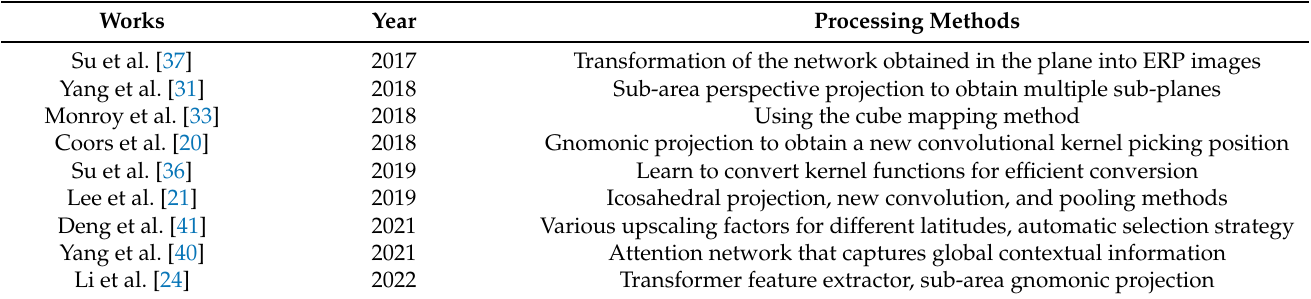
Table 1. A brief summary of studies undertaken in recent years for 360° omnidirectional images and their approach to dealing with distortion and